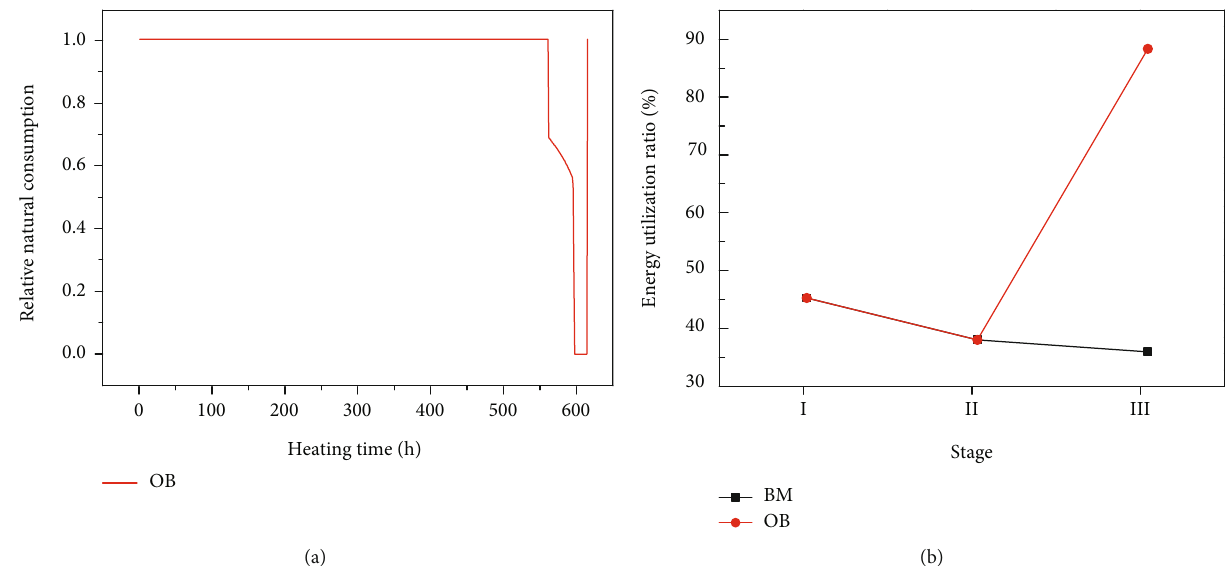
Figure 6: Relative natural gas consumption ( G mode.